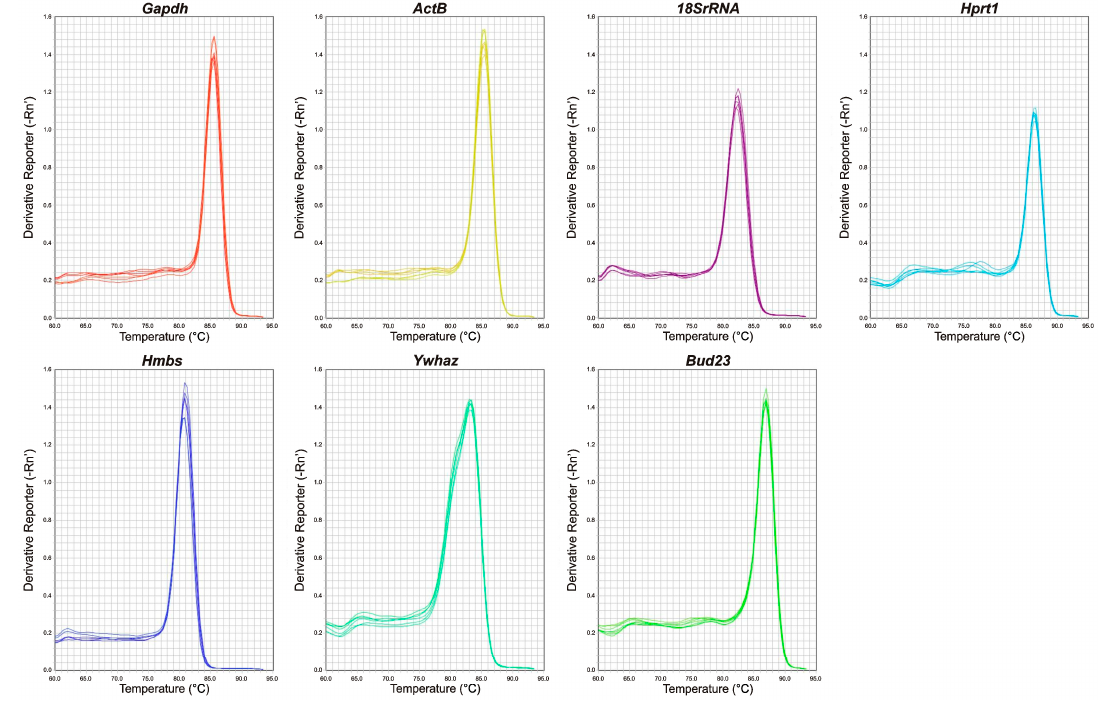
Figure 1. Validation of qRT-PCR primers. Melting curve analysis for testing the specificity of gerbil primers for candidate reference genes. A single peak indicates a single PCR product.